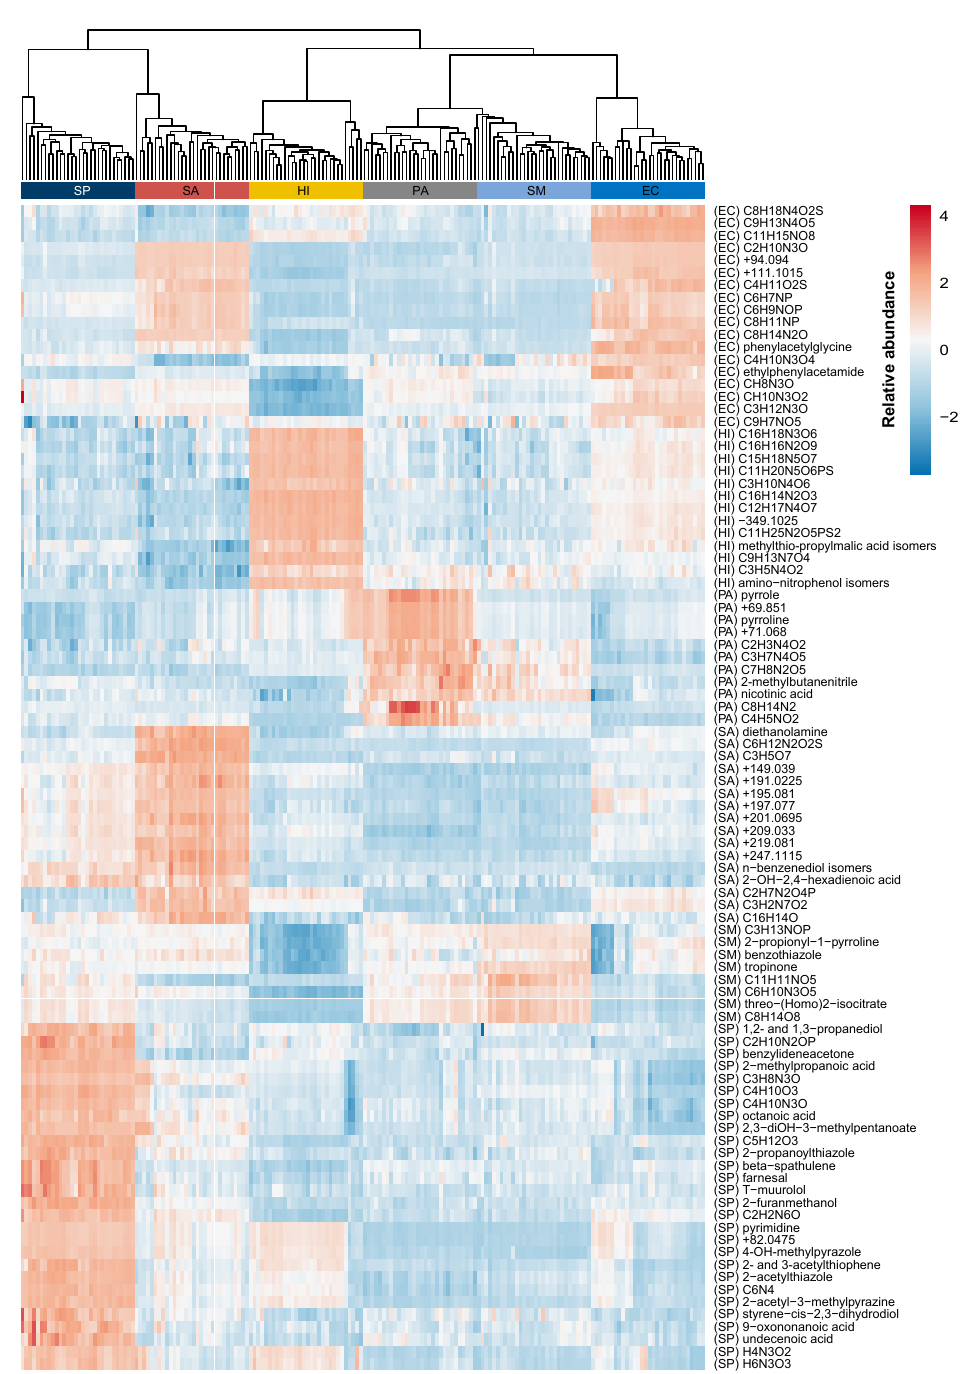
Figure 4. Heatmap of the 94 selected m / z -features across all 6 pathogen groups. Cell colors (range from red (high relative intensity) to blue (low relative intensity)) correspond to relative compound intensity (mean centered and divided by the standard deviation). The top dendrogram (Euclidean distance, average linkage method) shows the relationship between pathogen samples. EC: E. coli